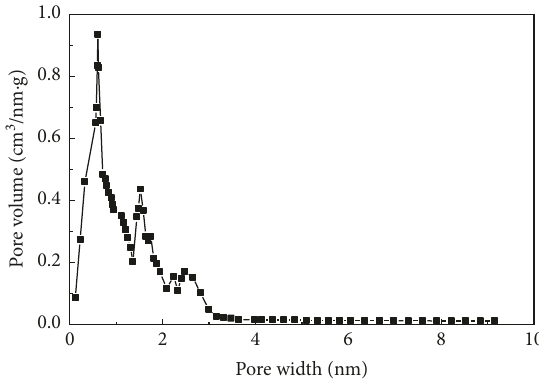
Figure 5: The pore-distribution curve of sludge carbon. Table 6: Surface characteristics and the iodine value of sludge carbon and activated carbon.